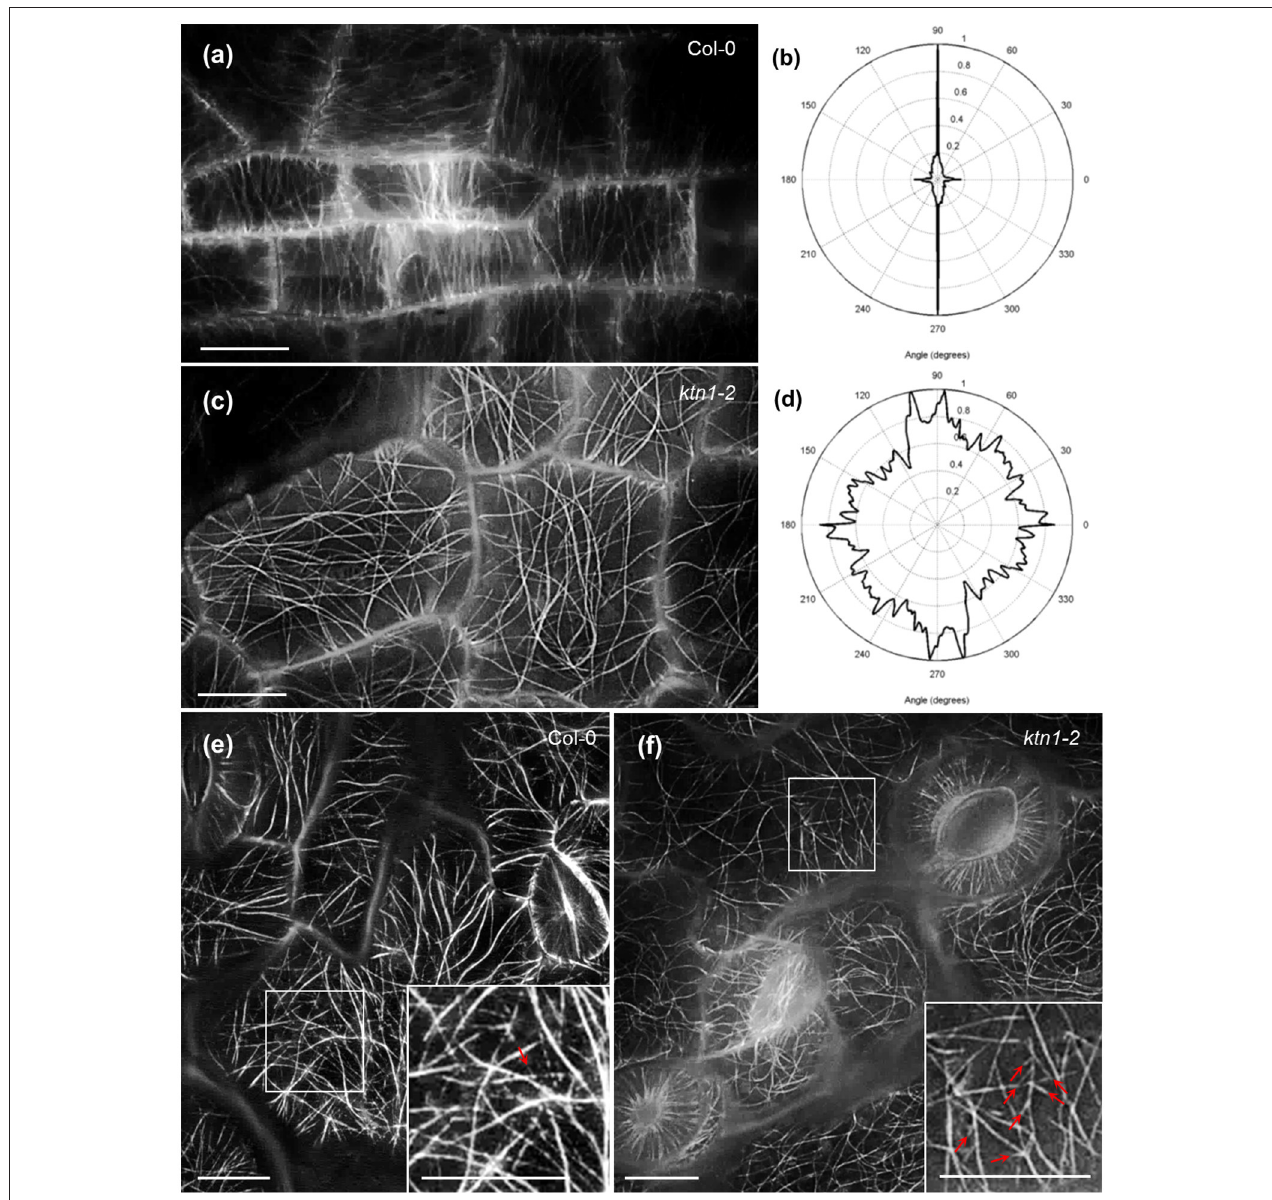
FIGURE 1 | Cortical microtubule organization in petiole and cotyledon epidermal cells of Col-0 and ktn1-2 mutant expressing a GFP-TUA6 microtubule marker after SIM 2D imaging. (a,b) Prevalent transverse orientation of cortical microtubules in Col-0 petiole epidermal cells (a) shown by very narrow angular distribution (b) . (c,d) Mixed orientation of cortical microtubules in ktn1-2 petiole epidermal cells (c) and its quantitative demonstration (d) . (e,f) Cortical microtubule organization in the cotyledon of Col-0 (e) showing a single branching event (inset; arrow) and ktn1-2 (f) showing multiple de novo branched initiation and formation of microtubules ( f ; arrows; inset). Scale bars: 10 µ